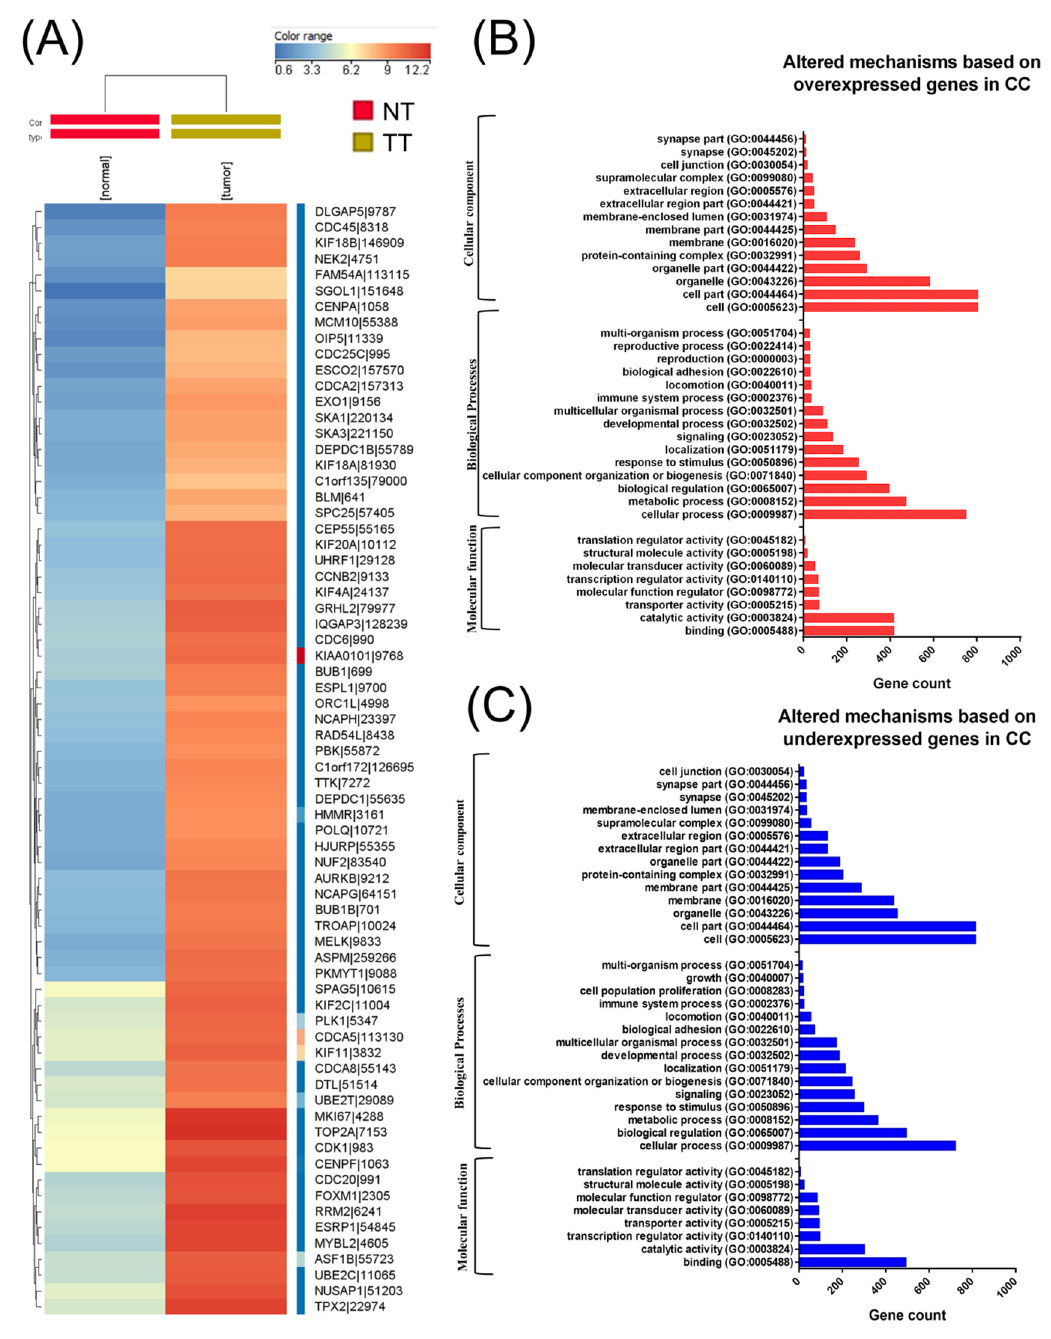
Figure 1. Biological interpretation of the cervical cancer (CC) altered gene expression signature. ( A ) A heatmap representation of The Cancer Genome Atlas (TGCA) gene expression data in CC, ( B ) gene ontology (GO) analysis of overexpressed genes, and ( C ) GO analysis of underexpressed genes using the Panther Gene ontology tool (available online: http://pantherdb.org); NT: normal tissue TT: tumoral tissue